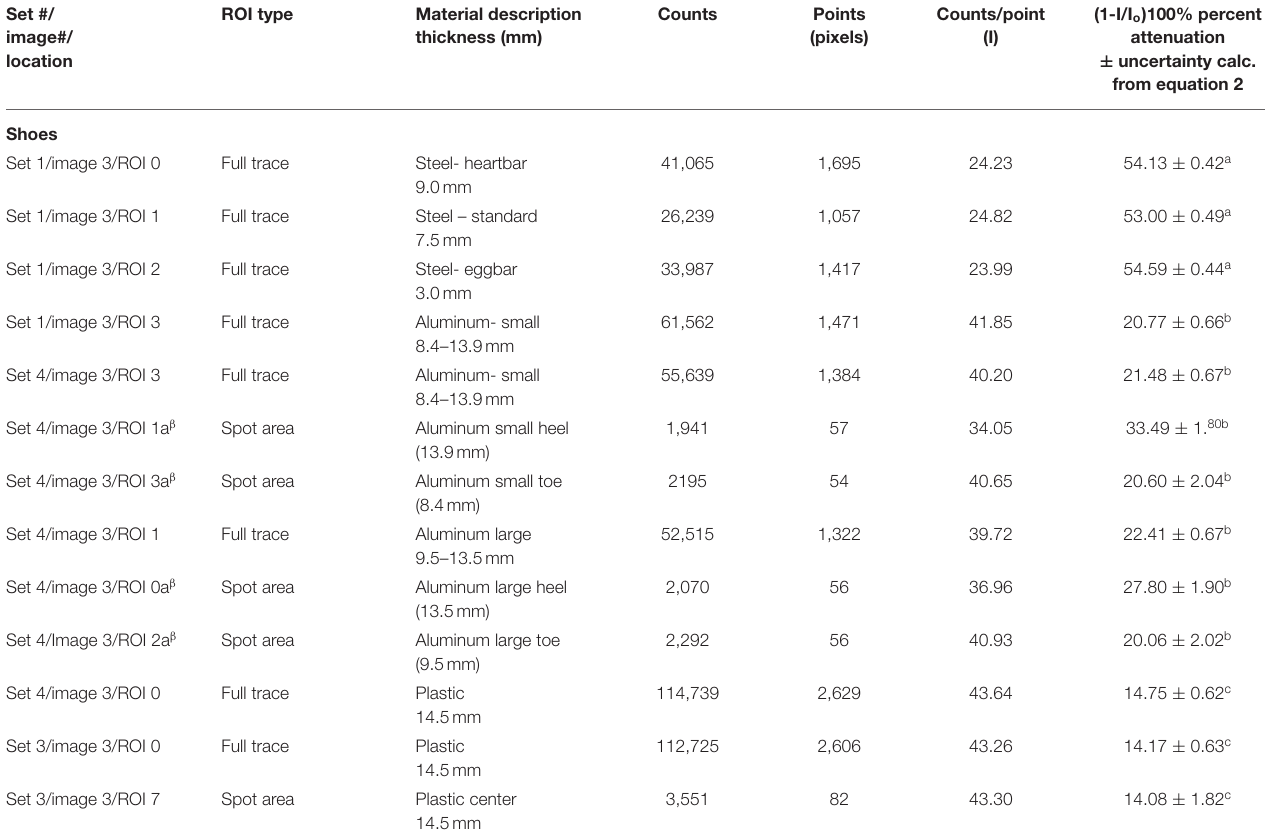
TABLE 4 | Data for Shoes (I) and Attenuation Calculation.